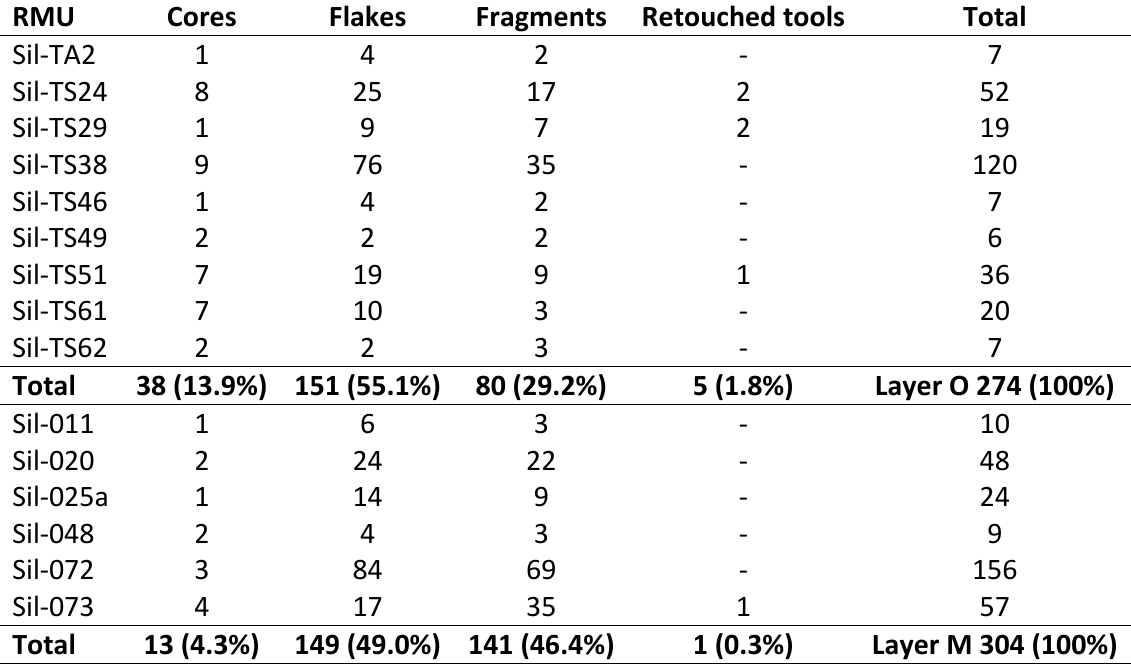
Table 2. Technological categories in RMU of layer O and layer